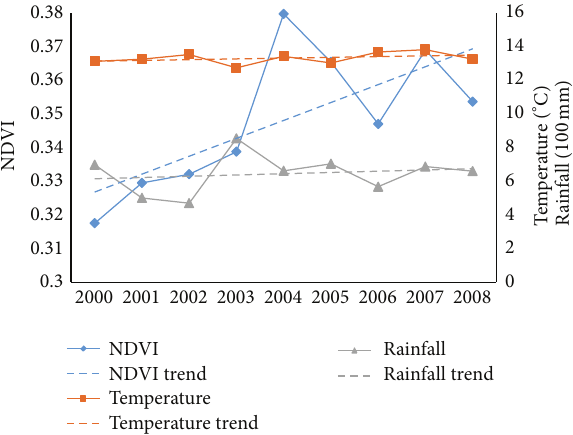
Figure 8: Changing trend of spatially aggregated annual NDVI, rainfall, and